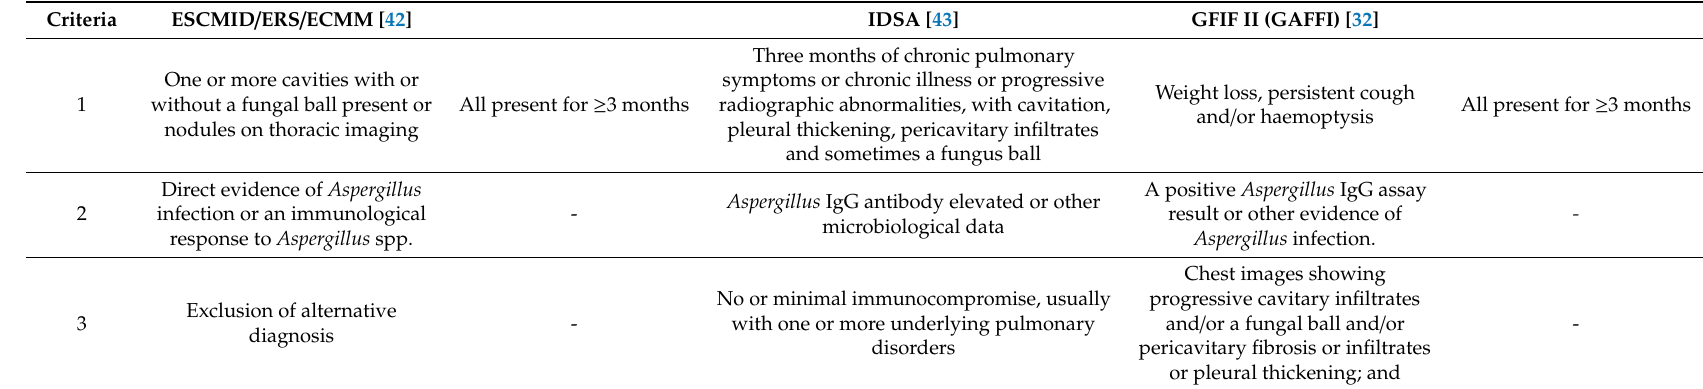
Table 3. Diagnostic criteria for chronic pulmonary